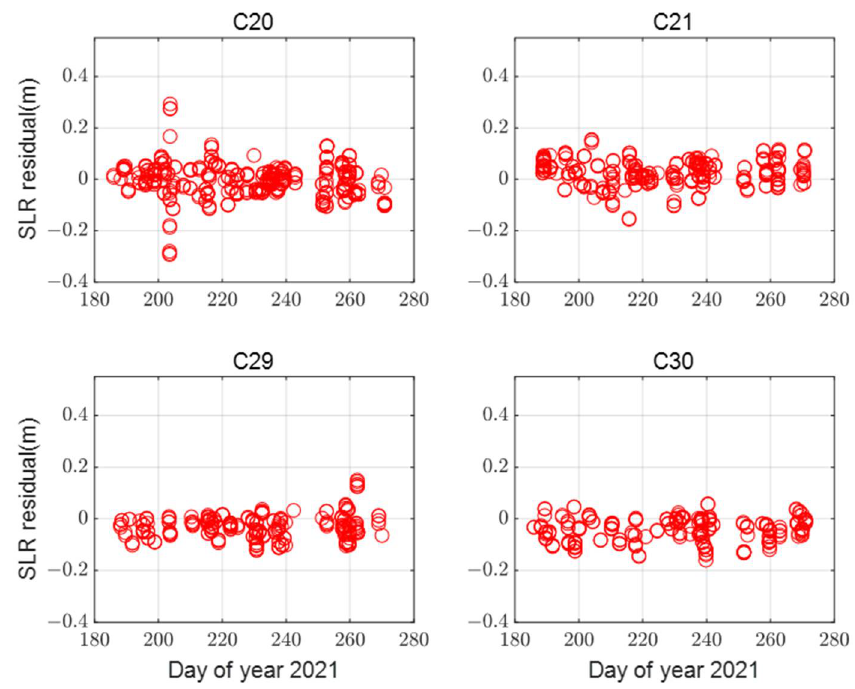
Figure 4. SLR residuals for BDS-3 satellites with prediction interval of 24 h (red circles represent SLR residuals). SLR